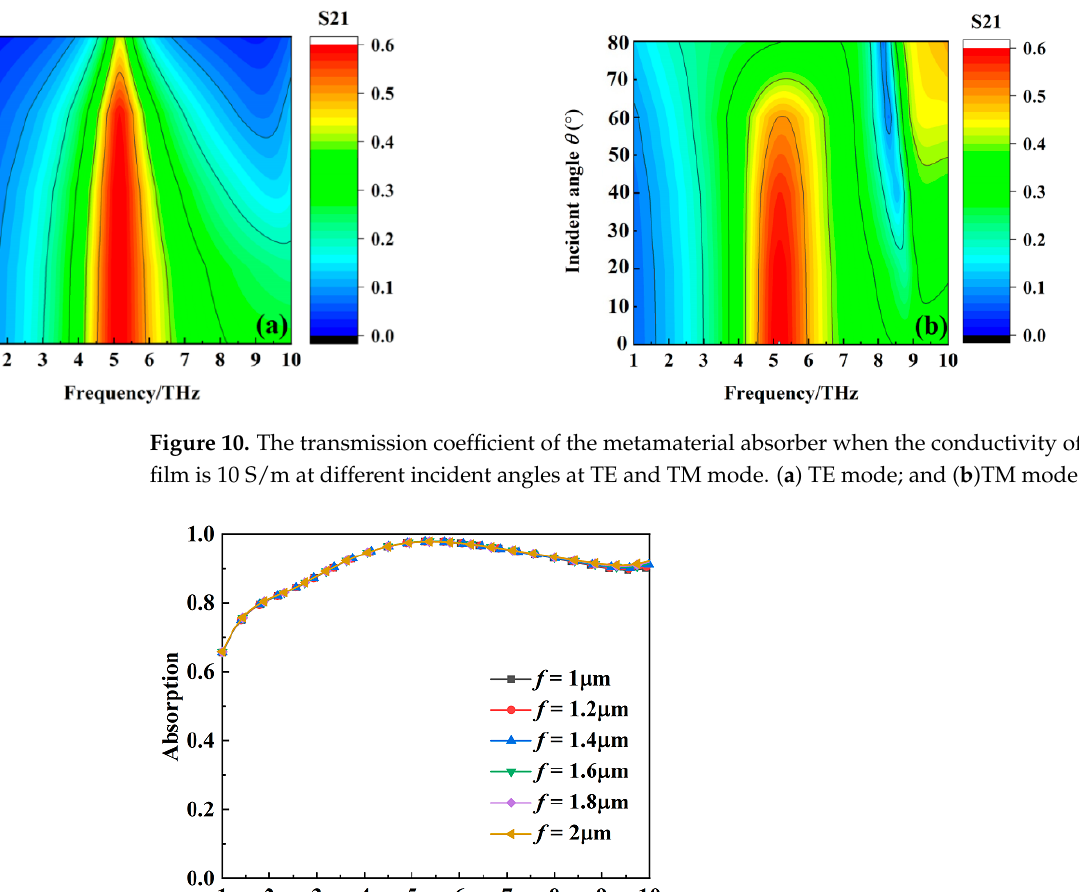
Figure 9. The absorption of the metamaterial absorber when the conductivity of VO 2 film is 2 × 10 5 S/m at different incident angles at TE and TM mode. ( a ) TE mode; and ( b )TM mode.